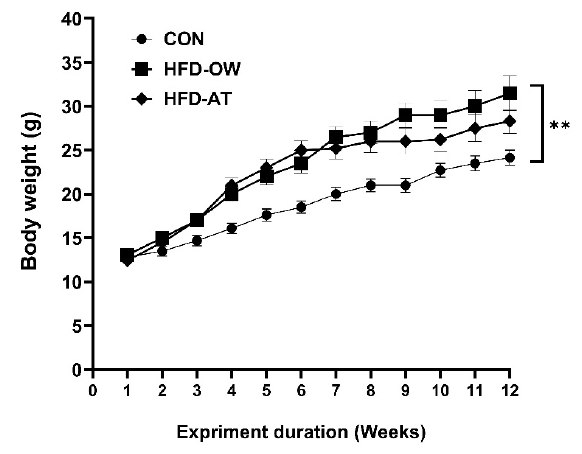
Figure 3. Relative gene expression of beta arrestin 1 (Arrb1) in the study groups. HFD-OW: High-fat diet-induced overweight; HFD-AT: high-fat diet with aerobic training. Data are presented as mean±SEM. Data were analyzed by one-way ANOVA followed by Tukey's test.